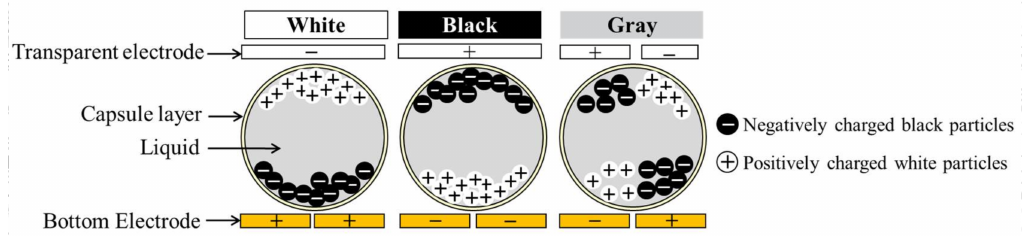
Figure 2. Working principle of the microcapsule-based electrophoretic